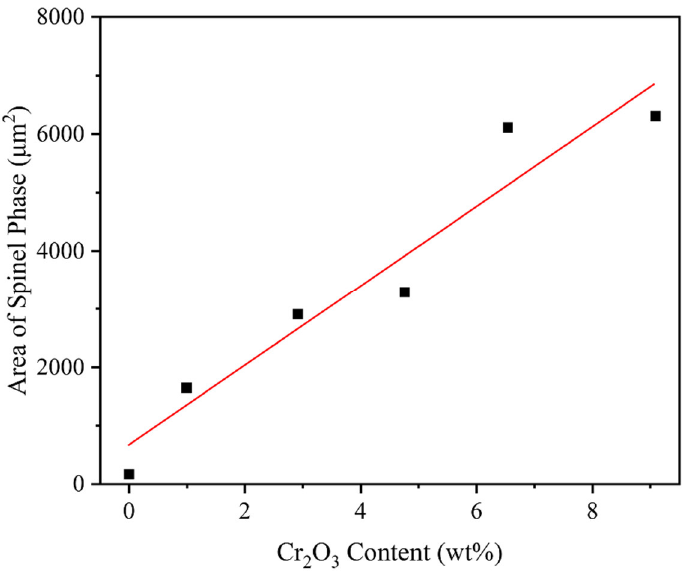
Figure 6. Relationship between Cr 2 O 3 content and the components of spinel at 1500 °C.